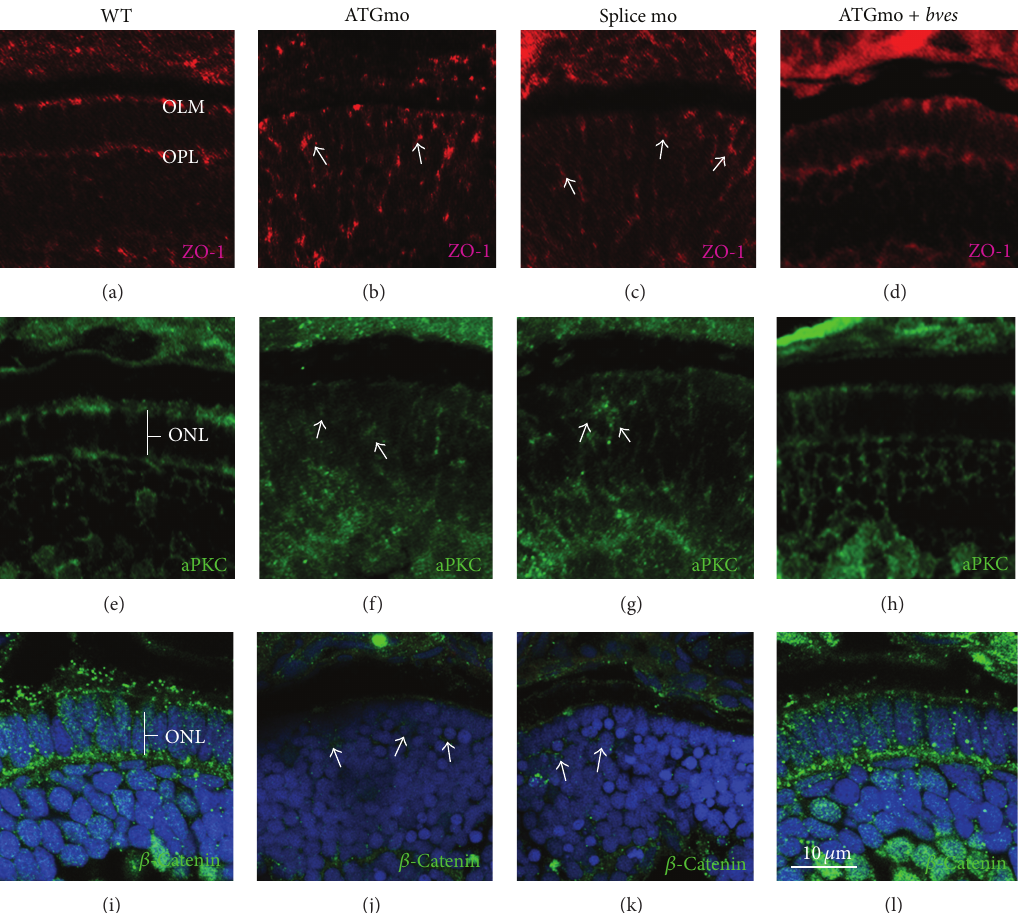
Figure 4: Adherens junctions were not formed in the outer limiting membrane of zbves morphants. Immunostaining of adherens junction-related molecules-ZO-1 (a)–(d), aPKC (e)–(h), and 𝛽 -catenin (i)–(l)—was carried out in the retinas of wild-type and zBves MO- injected embryos and zbves mRNA rescued morphants at 72 hpf. In wild-type embryos, 𝛽 -catenin obviously appeared in the apical site of photoreceptors (i), whereas it disappeared in zbve morphants (j), (k). The defect in this protein among morphants could be rescued by coinjection with zbve mRNA. Arrows indicate the apical edge. Nuclei were counterstained with DAPI (blue). Scale bar, 10 𝜇